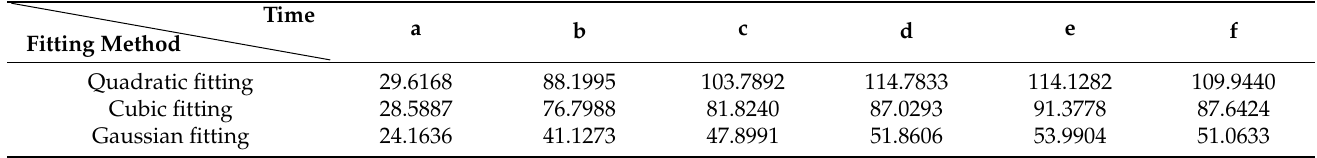
Table 2. Fitting error of three fitting methods ( ◦ C).